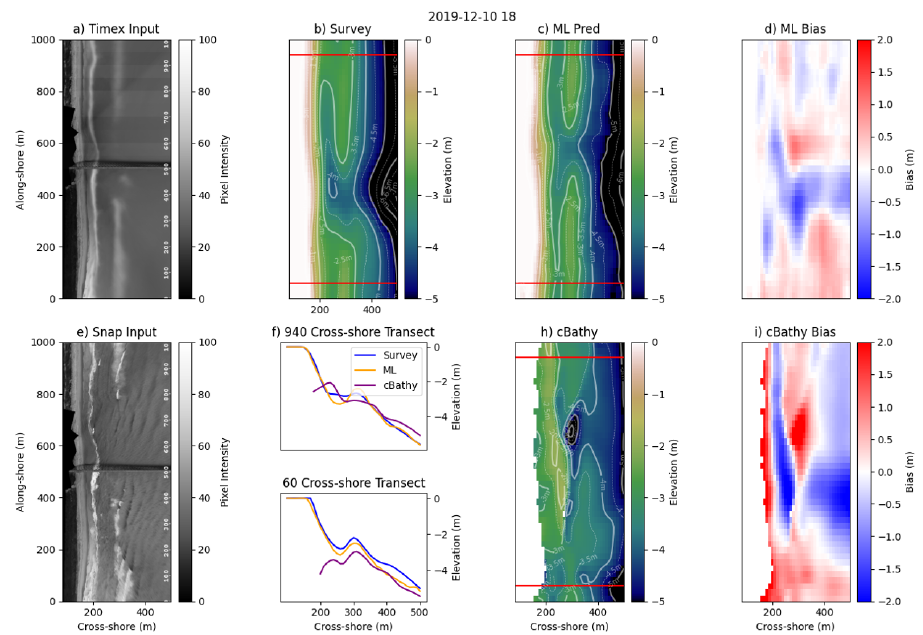
Figure 6. Additional plots evaluating the bathymetry from the fourth row of Figure 5 and comparing to the cBathy phase 2 output for the same time period. ( a ) shows the Timex image input. ( b ) shows the “truth” bathymetry. ( c ) ML predictions. ( d ) shows the ML depth bias. ( e ) shows the snap image input. ( f ) shows two cross-shore transects at the 60 and 940 along-shore position for the survey and the ML/cBathy methods. ( h ) shows the cBathy prediction, and ( i ) shows the cBathy bias. Wave height (H = 0.98 m), period (T = 9.09 s), wave direction (D = 108°).